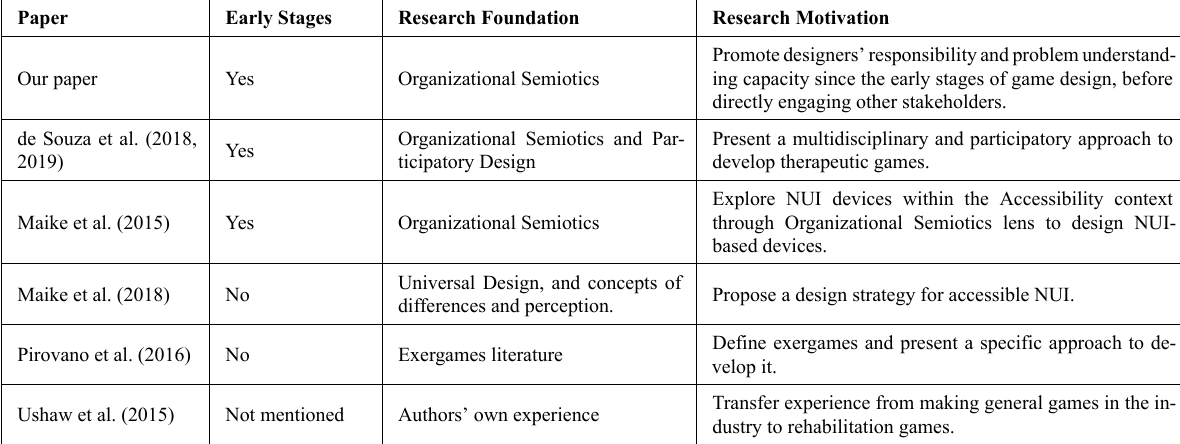
Table 1. Comparison of stages, research foundation and motivation of related